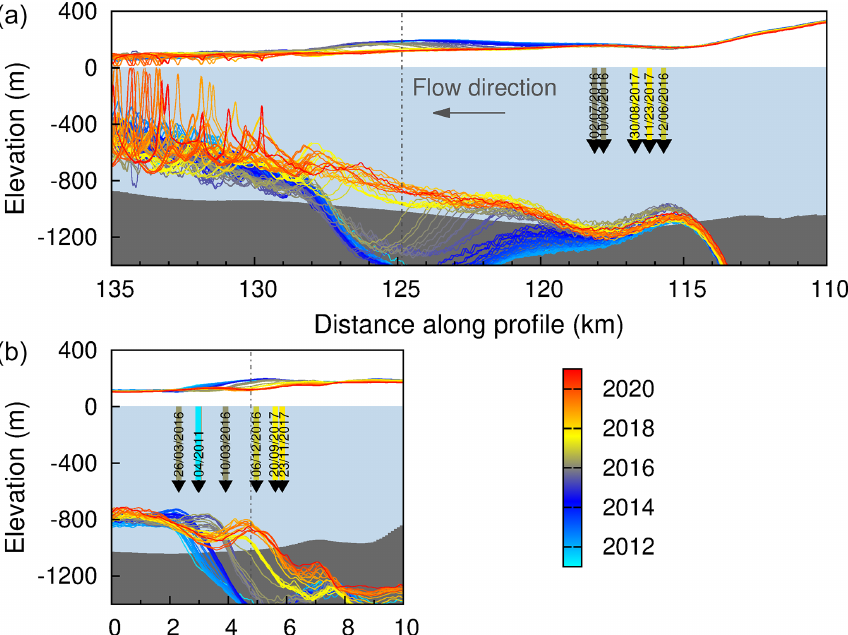
Figure 2. Ice surface elevation and hydrostatic thickness extracted from the flow-line profile (a) and the across-flow transect (b) marked in Fig. 1b. Where the ice base assuming hydrostatic thickness lies below the bedrock elevation this should be interpreted as a scaled height above flotation where the scaling factor is ρ w /(ρ w − ρ i ) ≈ 8. Vertical dashed lines mark the intersections of the two profiles. Coloured arrows indicate grounding line locations for 2011 (Rignot et al., 2016) and 2016/17 (Milillo et al., 2019) coloured according to date.